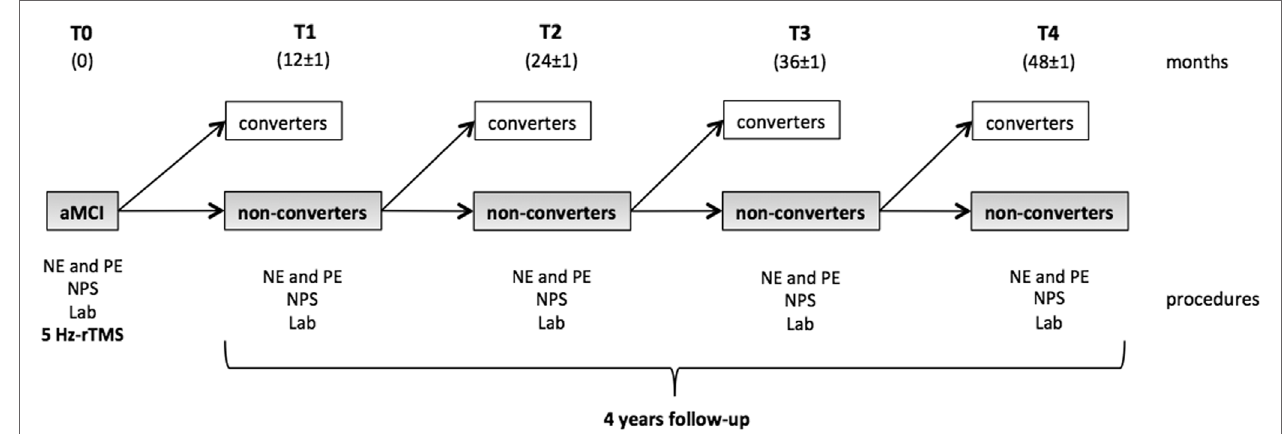
FigUre 1 | study design. At the baseline (T0), all the participants enrolled underwent a neuropsychological evaluation (NPS), a physical examination (PE), blood samples (Lab), and 5 Hz-rTMS. The cohort of aMCI subjects then started the longitudinal observational period. At each time point, the patients were reassessed in order to determine whether they had converted to dementia. Subjects who fulfilled the diagnostic criteria for aMCI (non-converters) at each time point continued the study to the subsequent follow-up visit. Converters were instead excluded from the